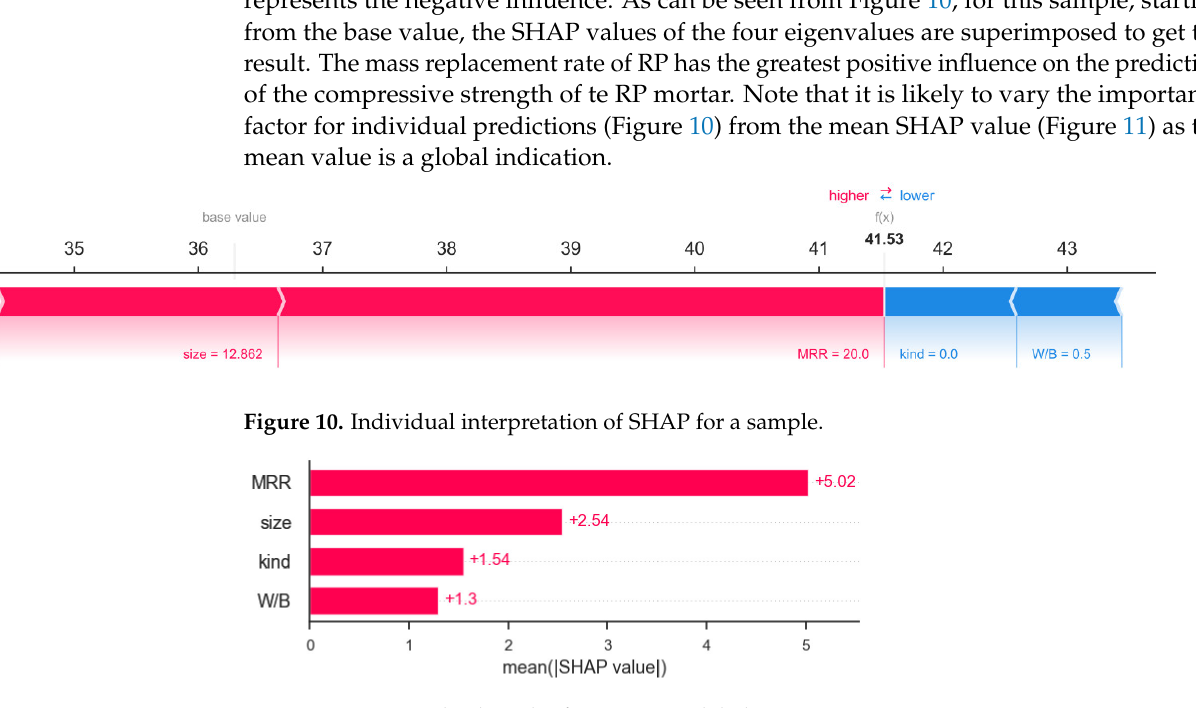
Figure 11. SHAP value bar plot for XGBoost global interpretation.